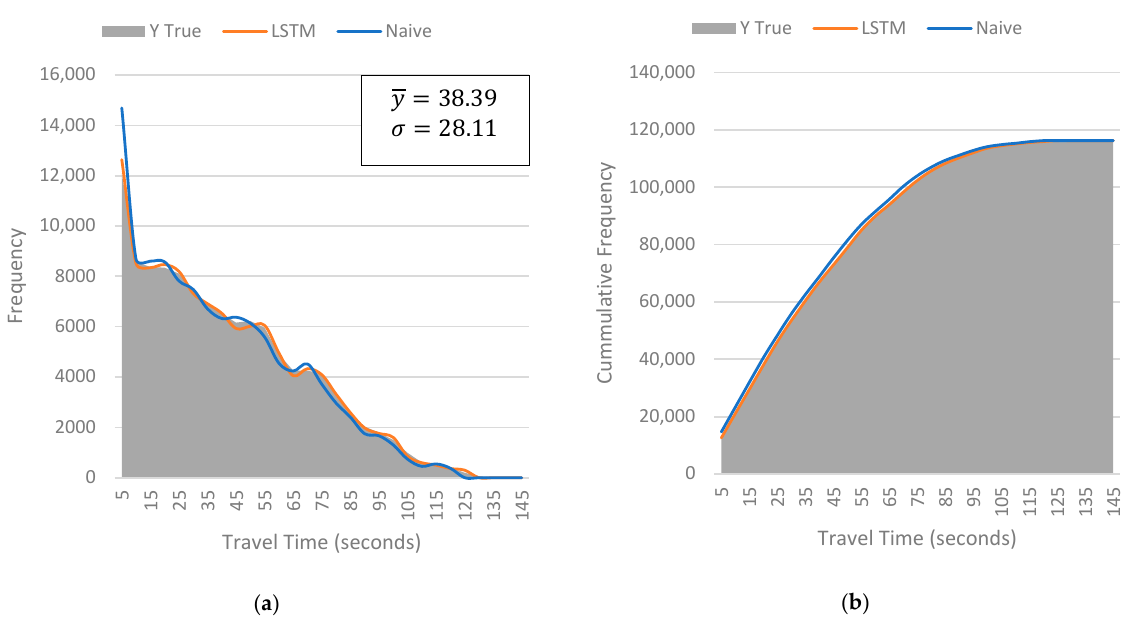
Figure 12. all_values dataset. ( a ) Frequency, mean and standard deviation; ( b ) Cumulative frequency.